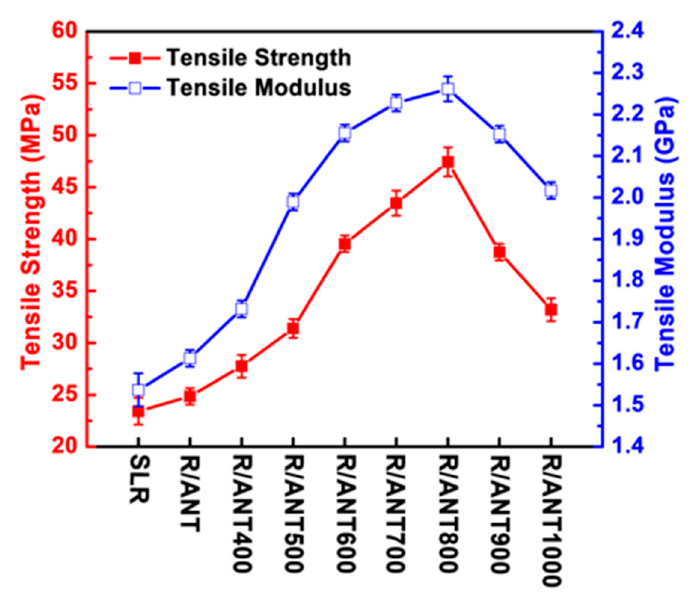
Figure 6. The complete dataset of tensile strength and elastic modulus of stereolithography (SLA) 3D printed samples prepared with the fillers of annealed anatase TNPs at different heat-treated temperatures.